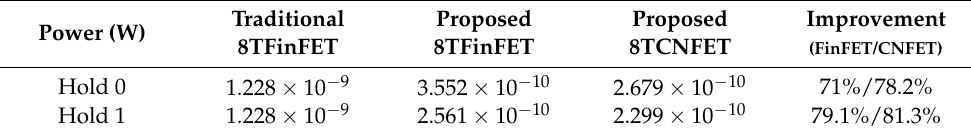
Table 8. Static power consumption comparison.